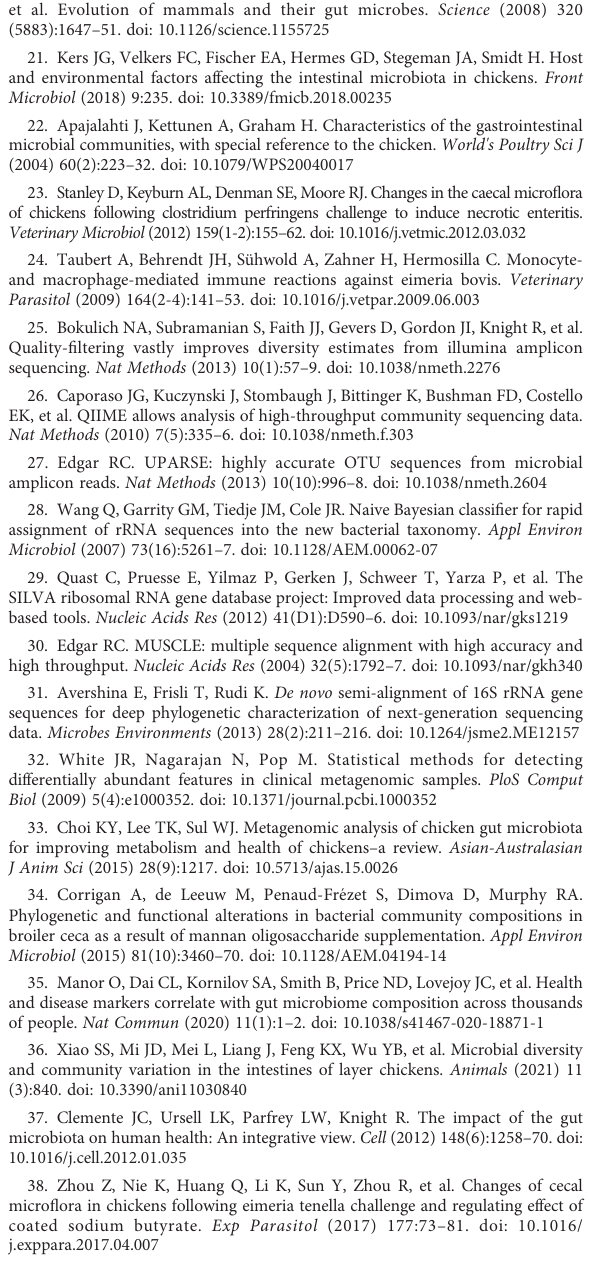
SUPPLEMENTARY TABLE 1 Data quality control (QC) statistical analysis of samples. SUPPLEMENTARY TABLE 2 Alpha diversity of sequence number of